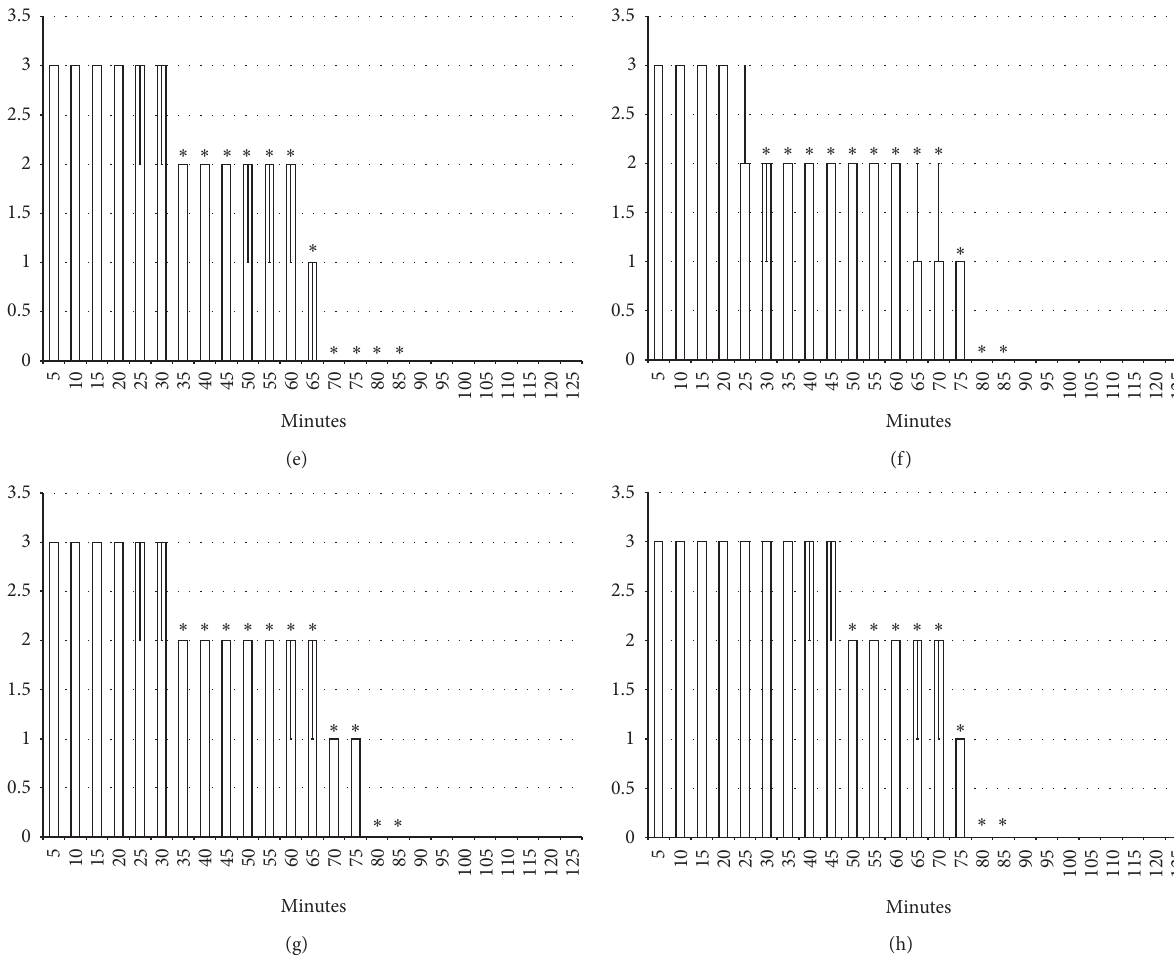
Figure 9: Spinal block (function failure and flaccid paralysis): intrathecal anesthesia prolonged hind limbs function failure and long-lasting flaccid paralysis (white bars). The prophylactic effect of the agents given immediately after lidocaine, saline 5ml/kg, BPC 157 10 μ g/kg, L- NAME 5mg/kg, and L-arginine 100mg/kg intraperitoneally, alone and/or together. Intrathecal anesthesia at the L4-L5 level rat spine, scored 0–3. (a) Saline (control). (b) L-NAME+L-arginine. (c) BPC 157. (d) L-arginine +BPC 157. (e) L-NAME. (f) L-NAME +BPC 157. (g) L-arginine. (h) L-NAME+L-arginine +BPC 157. Values are presented as min/med/max. ∗ P < 0 . 05 at least vs.